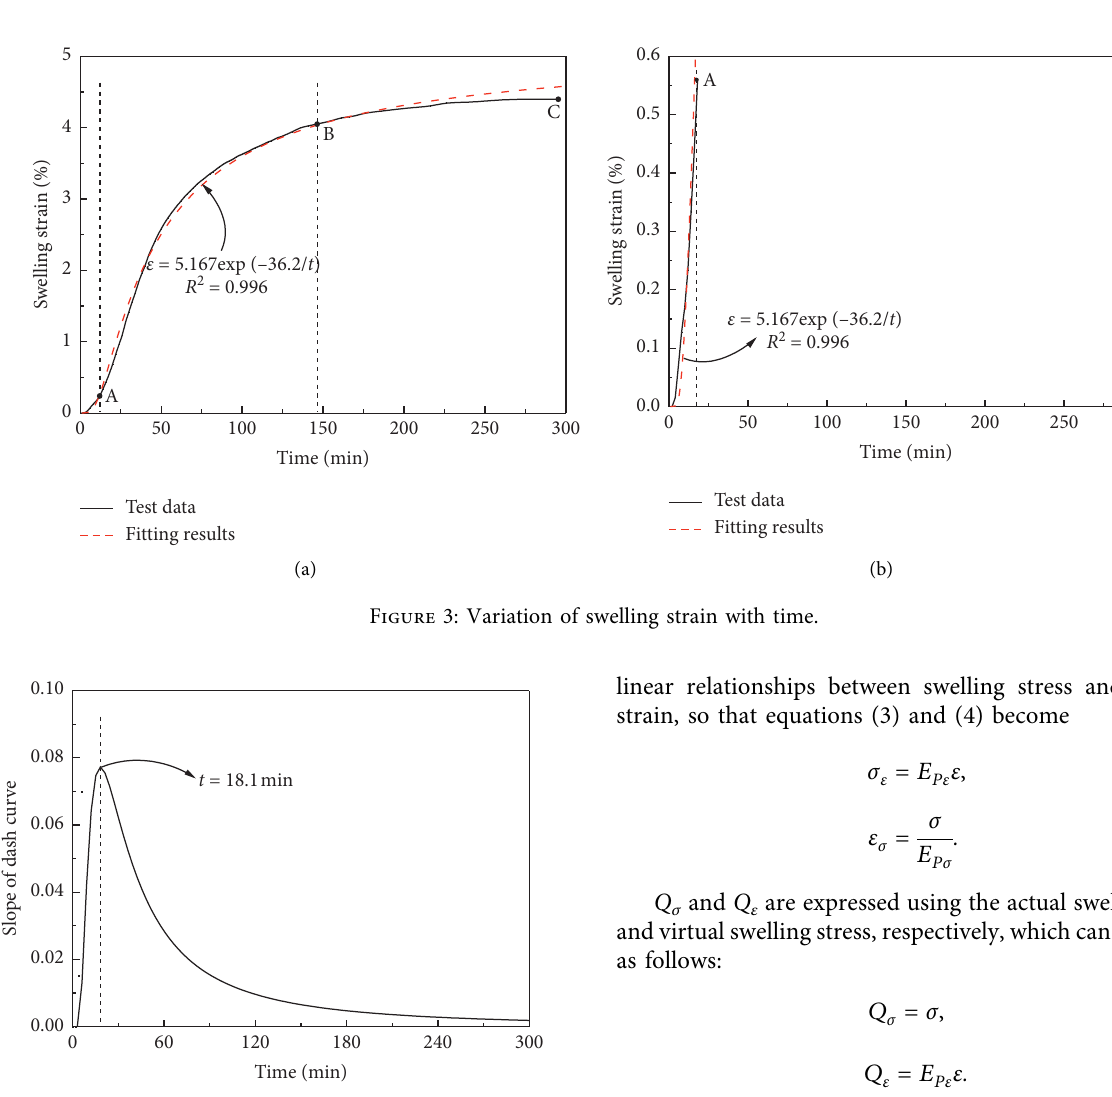
Figure 4: Variation of slope of dash curve with time. Table 2: Results of swelling stress